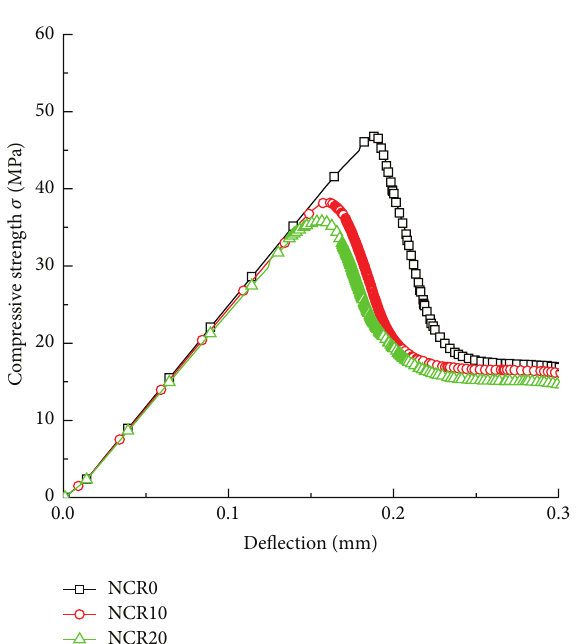
Figure 7: Load displacement 𝑃 - 𝛿 curve for various rubber contents taking into account the interface layer.